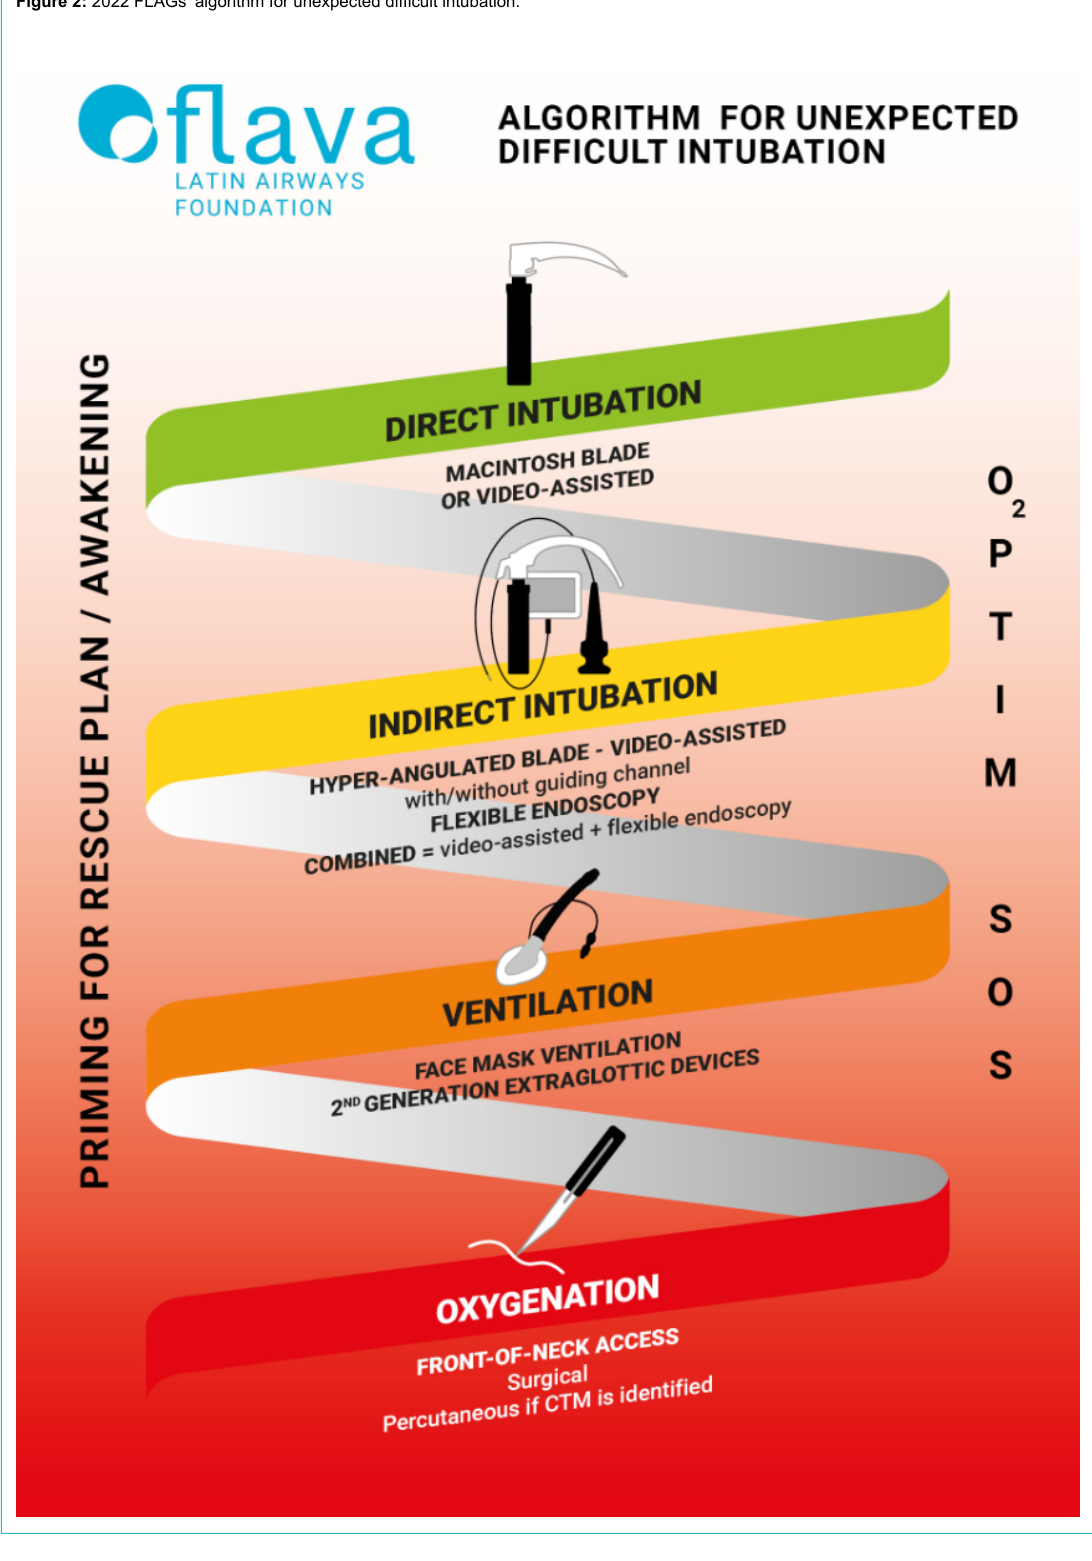
Figure 2: 2022 FLAGs’ algorithm for unexpected difficult